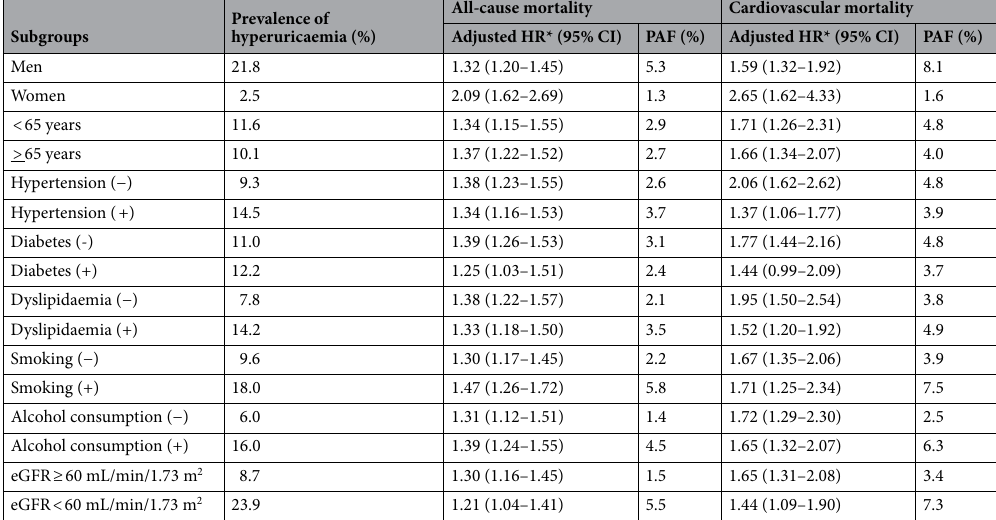
Table 3. Subgroup analyses for population attributable fraction of hyperuricaemia. eGFR estimated glomerular filtration rate; HR hazard ratio; CI confidence interval; PAF population attributable fraction; (+), present; (−), absent. *Adjusted for age, gender, body mass index, smoking, alcohol consumption, eGFR, hypertension, diabetes, and